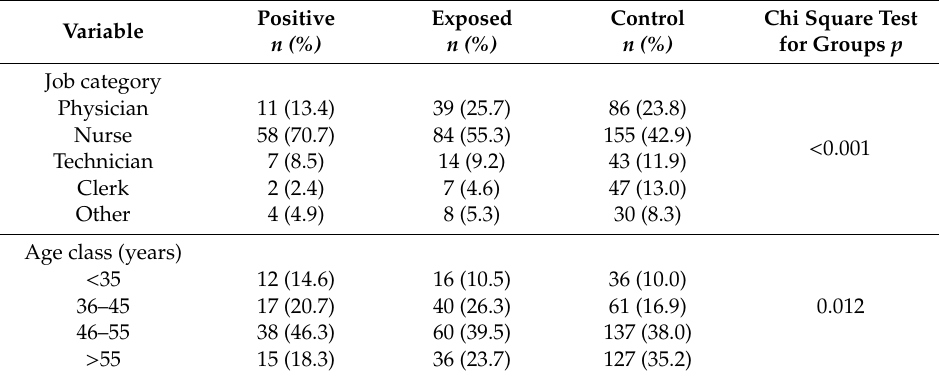
Table 2. Professional category and age class.